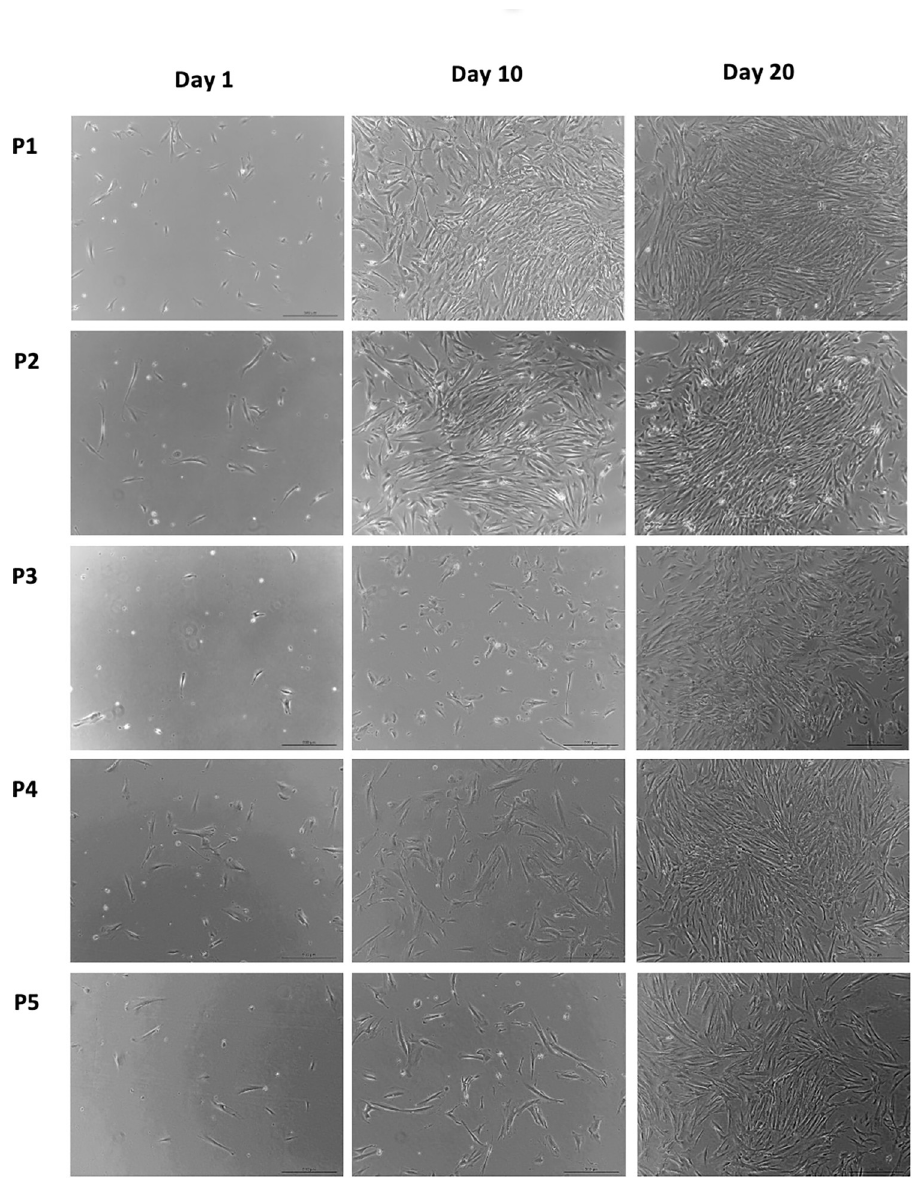
Fig 1. Photographs of cells from control sample on day 1, day 10, and day 20 for all 5 passages at 5x magnification (2 mm = 200 μ m).